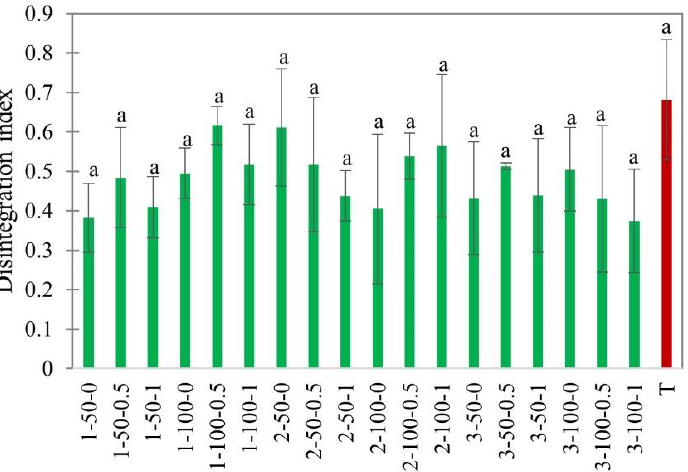
Figure 12. Disintegration Index of EHD (marked in green and labeled as thickness-slice load density-airflow) and hot air-dried (marked in red as T) apple slices. Different lower-case letters indicate statistically significant differences ( p < 0.05).